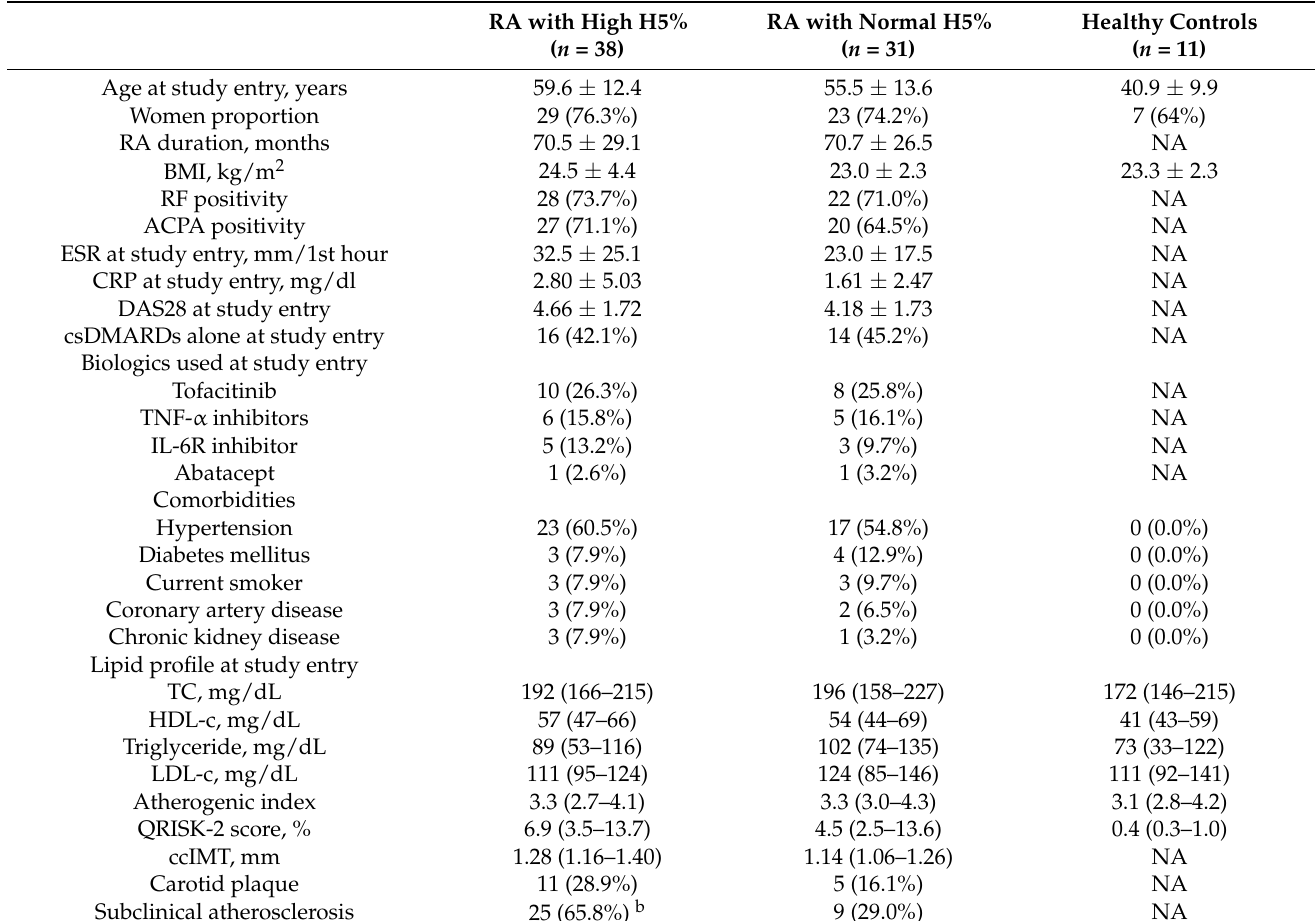
Table 1. Demographic and laboratory data in rheumatoid arthritis (RA) patients with a high percentage of H5 in high-density lipoprotein cholesterol (HDL-c) (H5%), RA patients with normal H5%, and healthy controls a